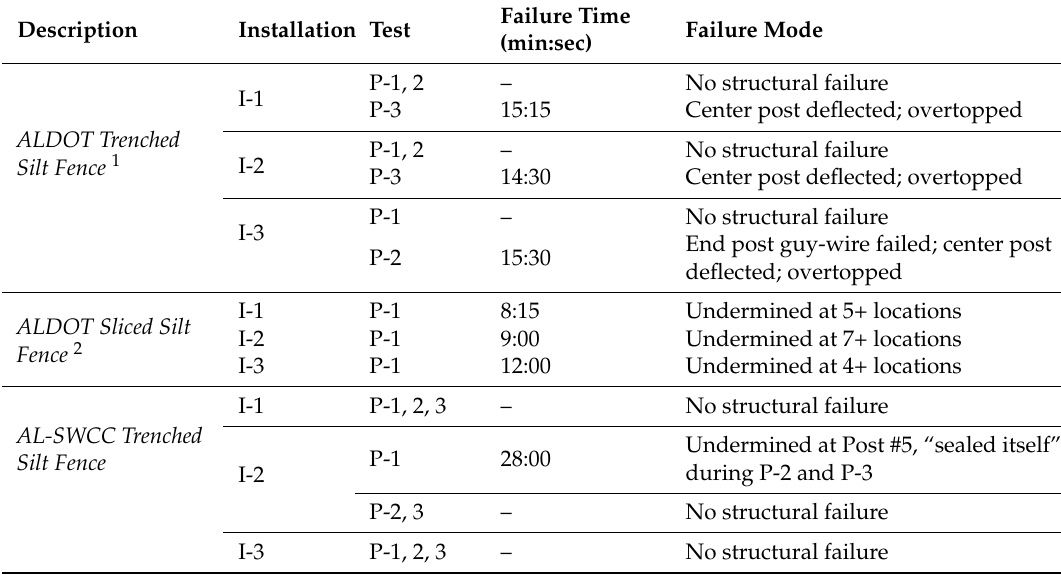
Table 1. Summary of Silt Fence Failure